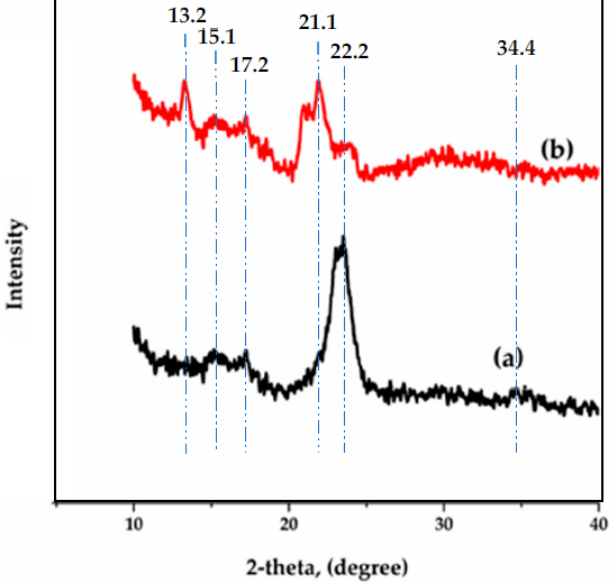
Figure 7. XRD Spectra of ( a ) pure cotton fibers ( b ) cotton fibers reinforced alginate hydrogel composite fiber.